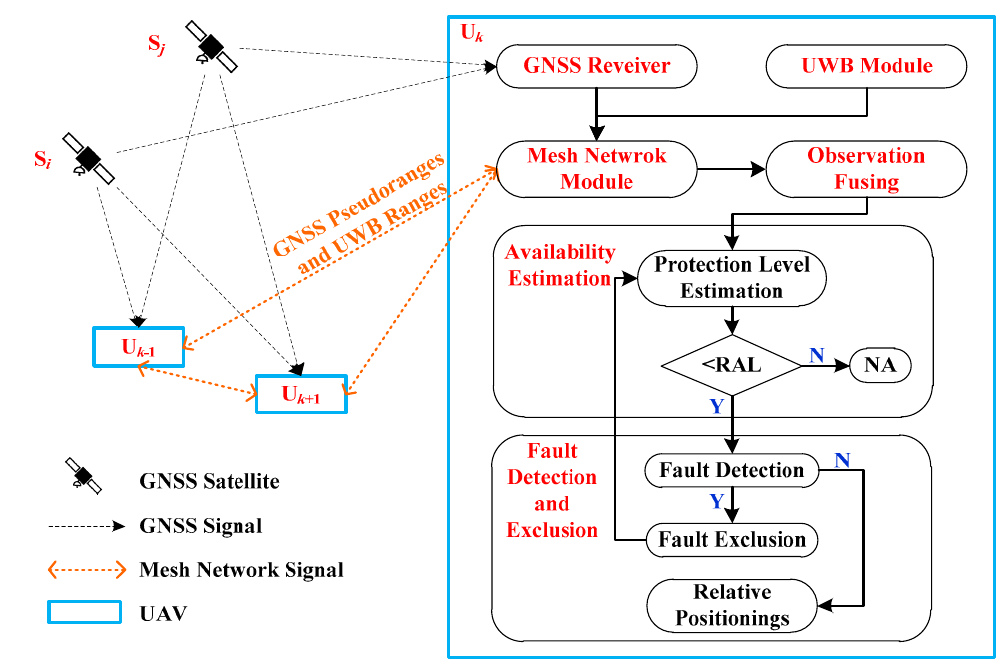
Figure 1. The framework of the proposed integrity monitoring method for multi-unmanned aerial vehicle (UAV) relative navigation.